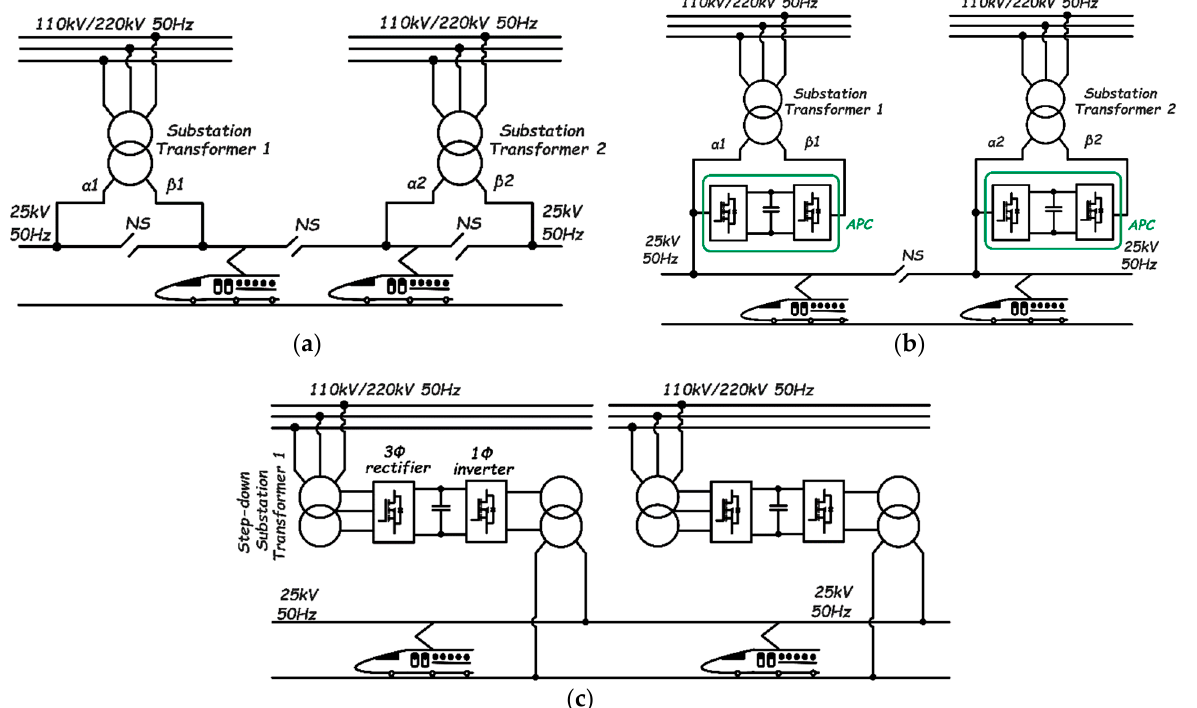
Figure 14. Traction power supply systems: ( a ) traditional; ( b ) co-phase; ( c ) advanced co-phase.